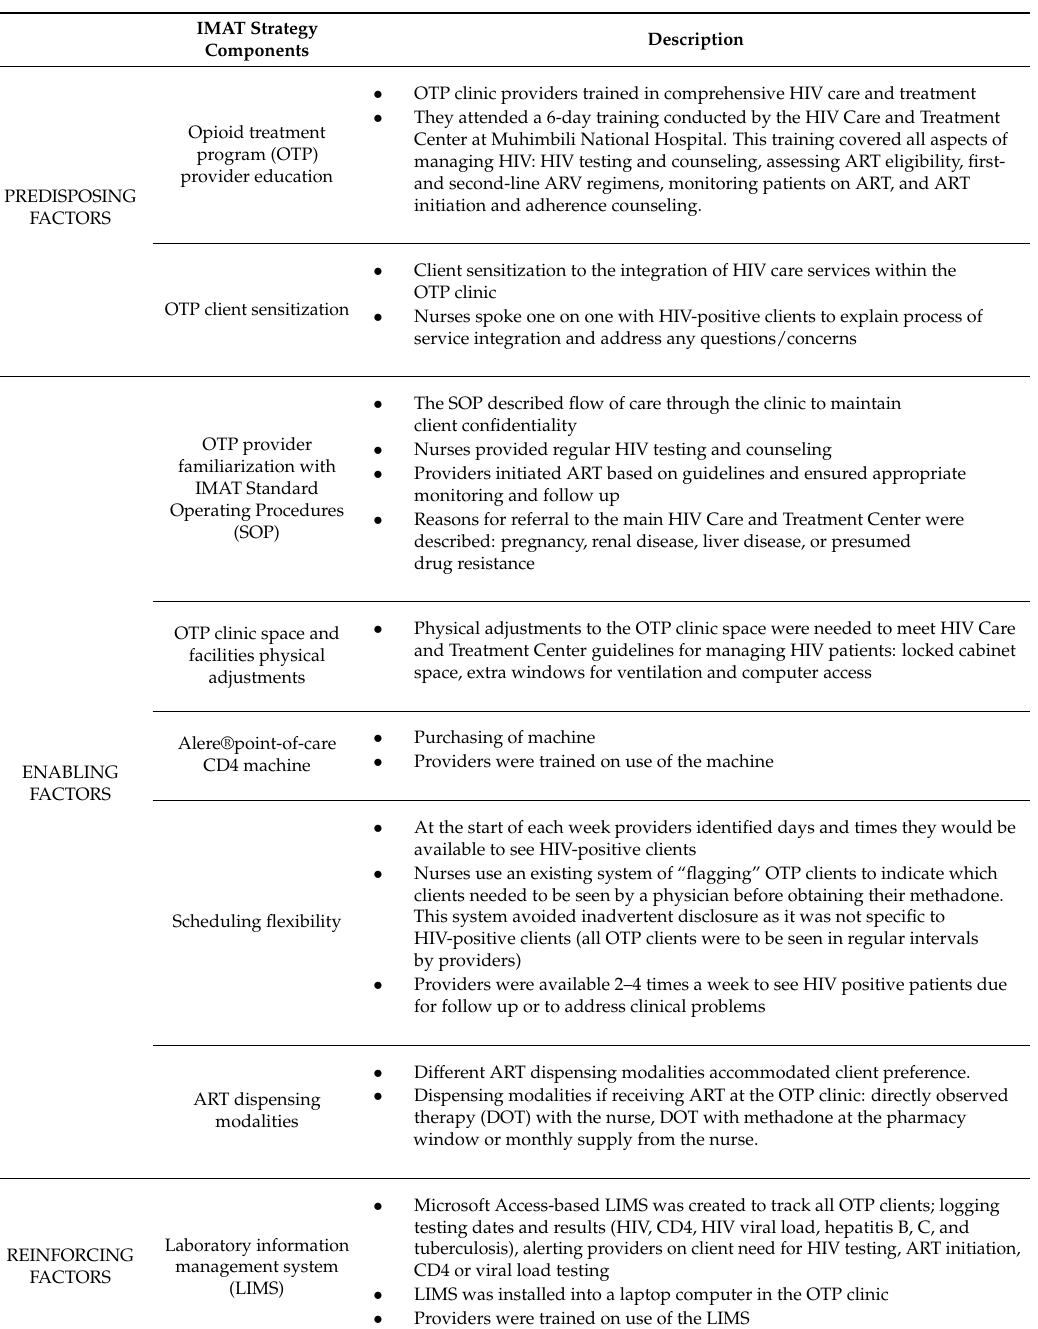
Table 1. Describing Components of the IMAT